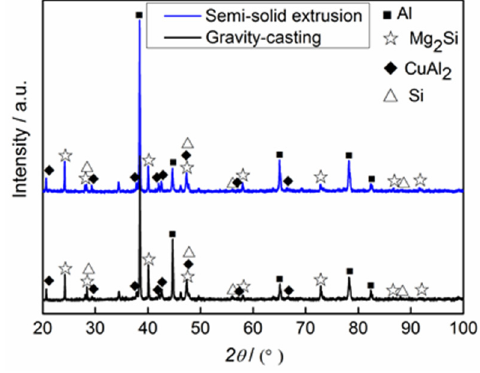
Figure 2. XRD spectra of Mg 2 Si–Al composites.